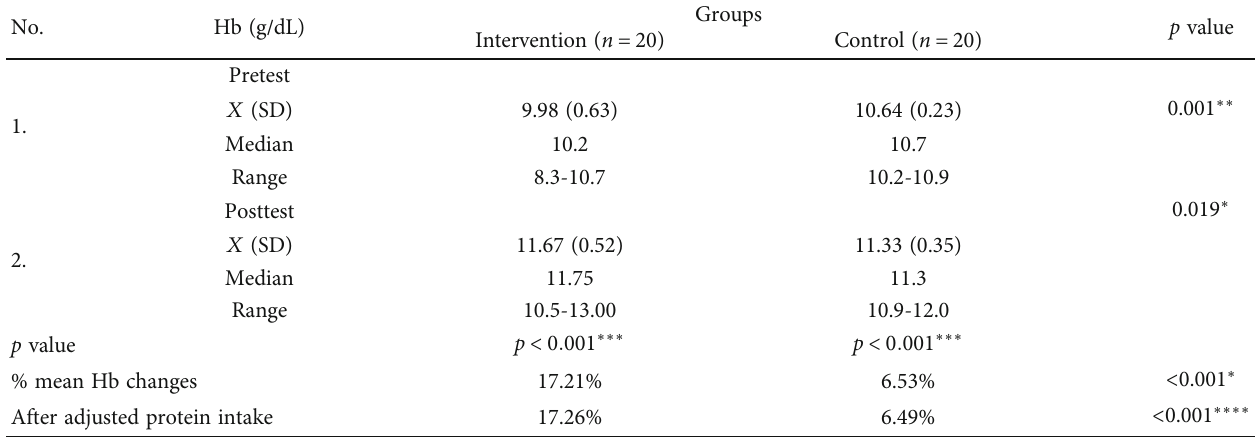
Table 6: Comparison of hemoglobin levels in both